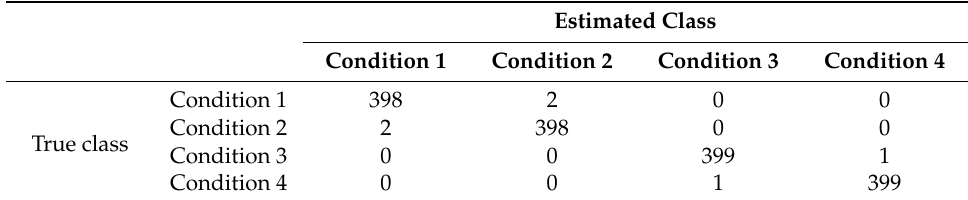
Table 5. Confusion matrix of the method.